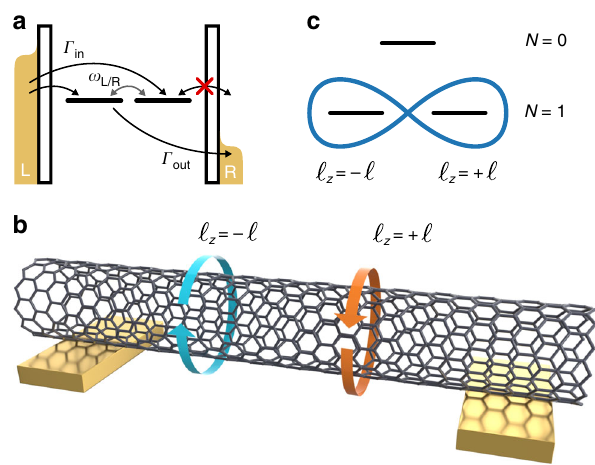
Fig. 1 All-electronic dark states in a carbon nanotube quantum dot. a Quantum dot setup to probe coherent population trapping in a dark state (DS). For the chosen bias voltage polarity, an electron can enter a DS from the left lead but it cannot leave it by tunneling to the right lead. Precession allows population transfer from the dark state to the coupled state (CS). b A CNT features degenerate angular momentum states. Linear combinations of angular momentum states for single-electron occupancy ( N = 1) of a given nanotube shell can give rise to CS and DS. The latter is represented by the eight-shaped orbital in panel ( c ). c Effective Lambda-system for coherent population trapping in a CNT quantum dot. Because an electron in the DS cannot leave the carbon nanotube, the state N = 0, corresponding to an empty shell con fi guration, can no longer be reached. CNT